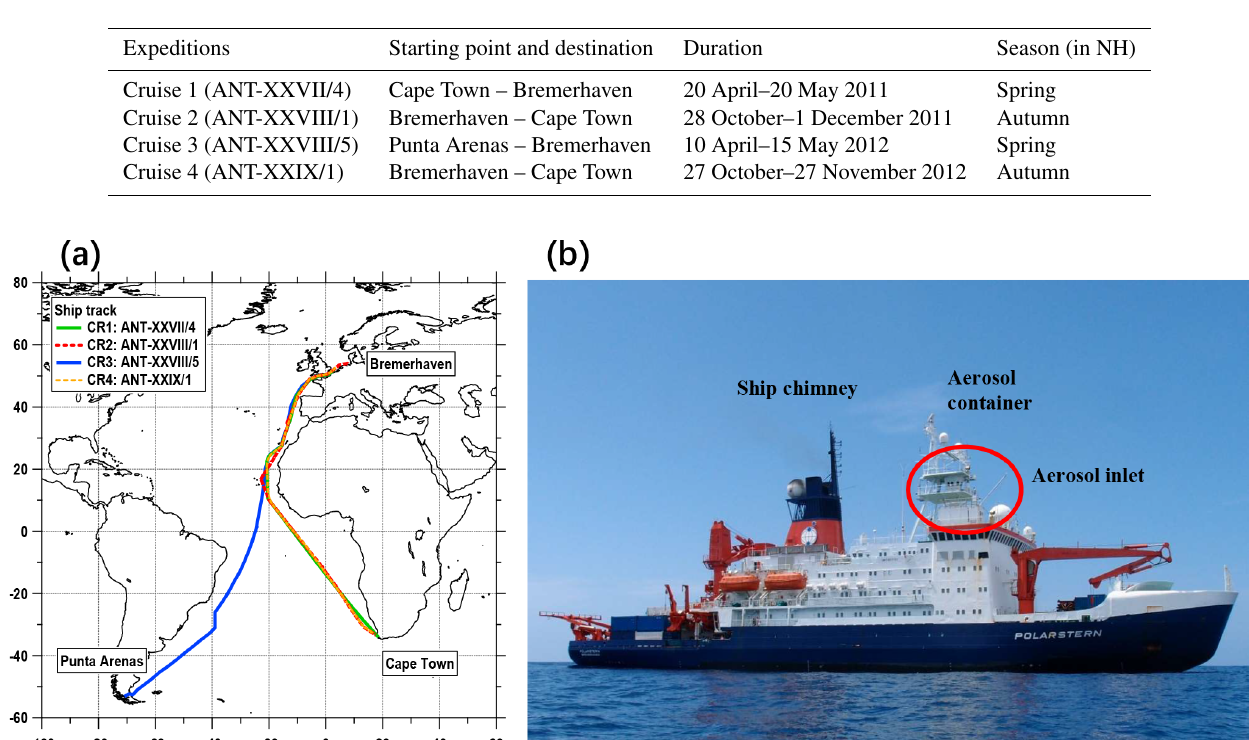
Table 1. The description of four cruises.